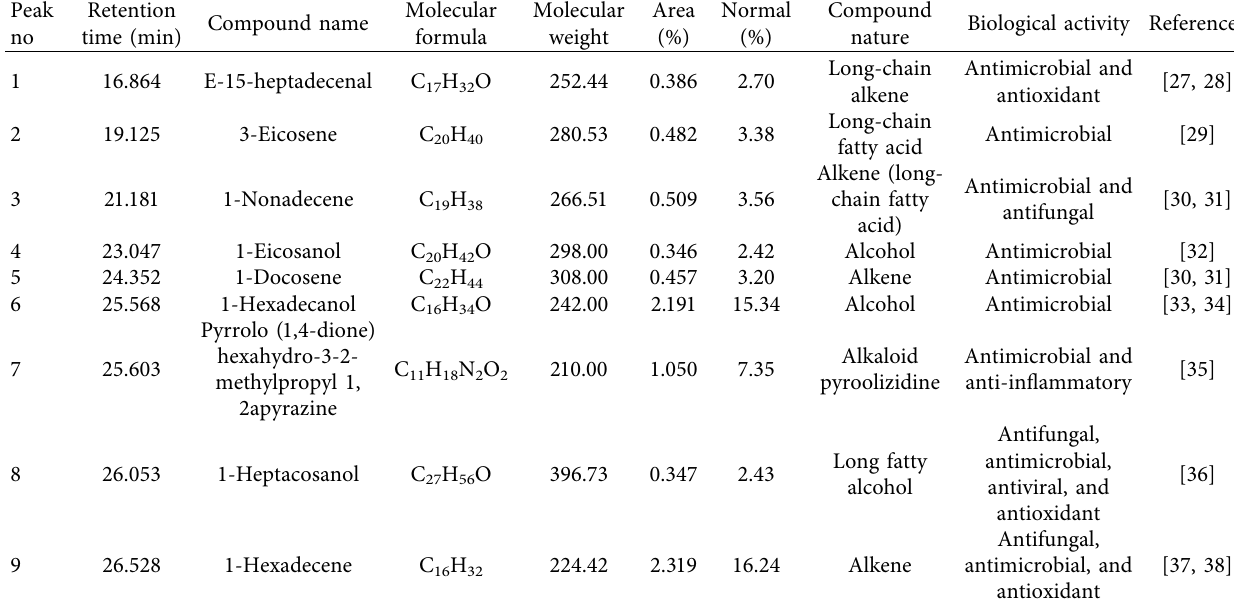
Table 9: Compounds identified in DO5 subfraction (BF2124) by GC-MS analysis and a review of their documented antimicrobial activities. Peak no